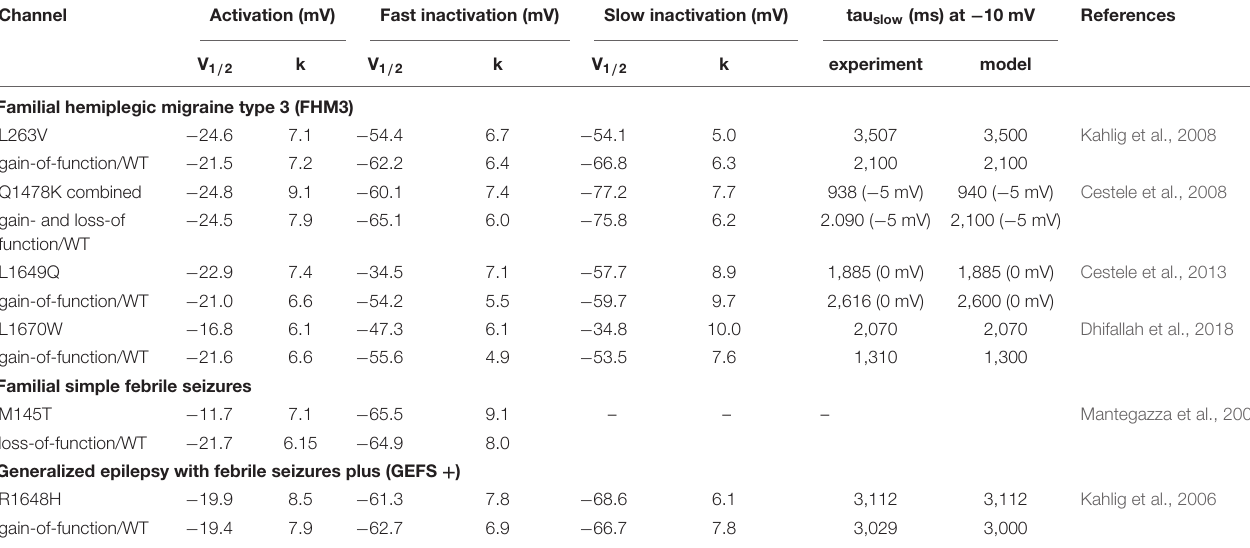
TABLE 1 | Biophysical parameters for activation, fast inactivation and slow inactivation of WTs and mutants of Na V 1.1 channel. Channel Activation (mV) Fast inactivation (mV) Slow inactivation (mV) tau slow (ms) at − 10